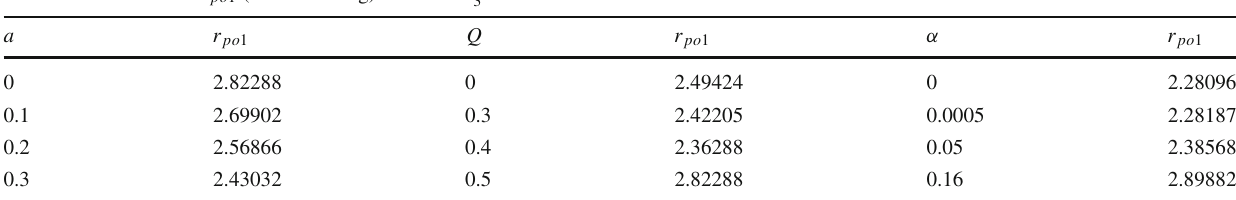
Table 2 Photon orbits r po 2 (counter rotating) for ω = − 2